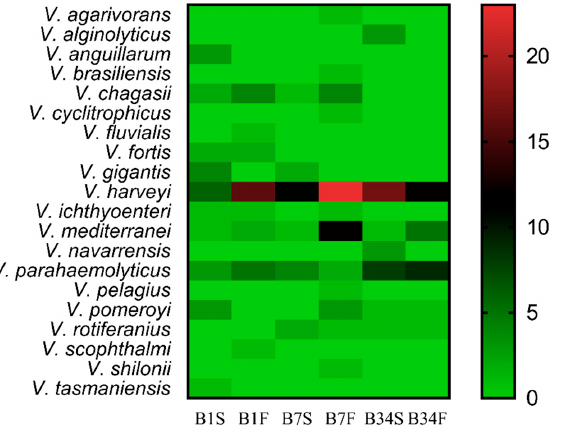
Figure 2. Distribution of Vibrio spp. among the sampling sites. Heatmap of the distribution of Vibrio species identified by MALDI-TOF MS in each sampling location, from the subsurface as well as from the bottom water samples. The color gradient key displays a linear scale of the MALDI-TOF MS identified Vibrio coverage as a measure of the absolute abundance in each sampling site. B1S: site 1 subsurface; B1F: site 1 bottom; B7S: site 7 subsurface; B7F: site 7 bottom; B34S: site 34 subsurface; B34F: site 34 bottom. The highest number of identified Vibrio spp. was detected in March, followed by Feb- ruary and April. However, no statistically significant differences were detected between the abundance of Vibrio spp. and sampling expeditions ( p = 0.071). The pathogenic species V. harveyi and V. parahaemolyticus were detected in all sampling expeditions. Although a selective culture medium for the genus Vibrio was used, eight other bacterial genera were identified, being Photobacterium spp. and Aeromonas spp. the most frequently isolated (Fig- ure S2).